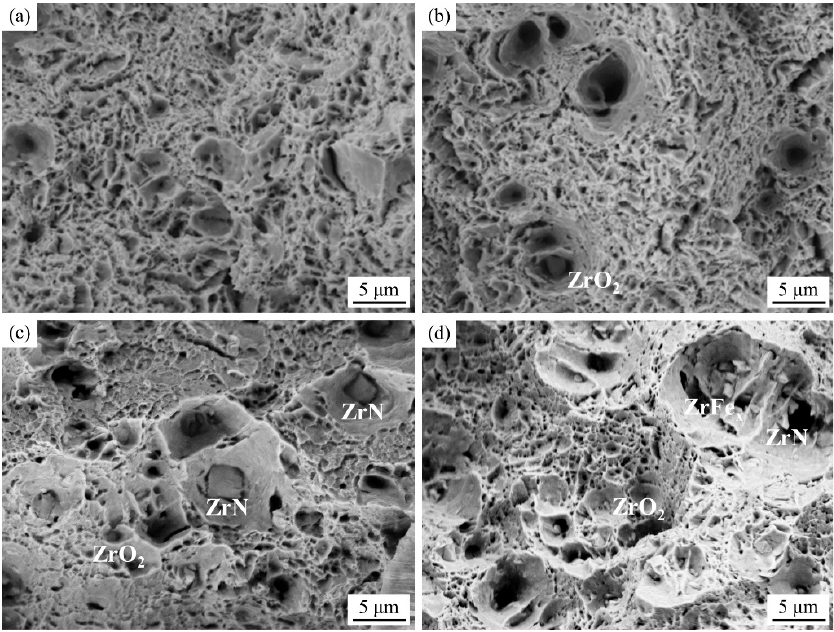
Figure 5. Microscopic fracture morphology of the steels at room temperature. ( a ) 0ZrA, ( b ) 0.004ZrA, ( c ) 0.037ZrA, and ( d ) 0.098ZrA.